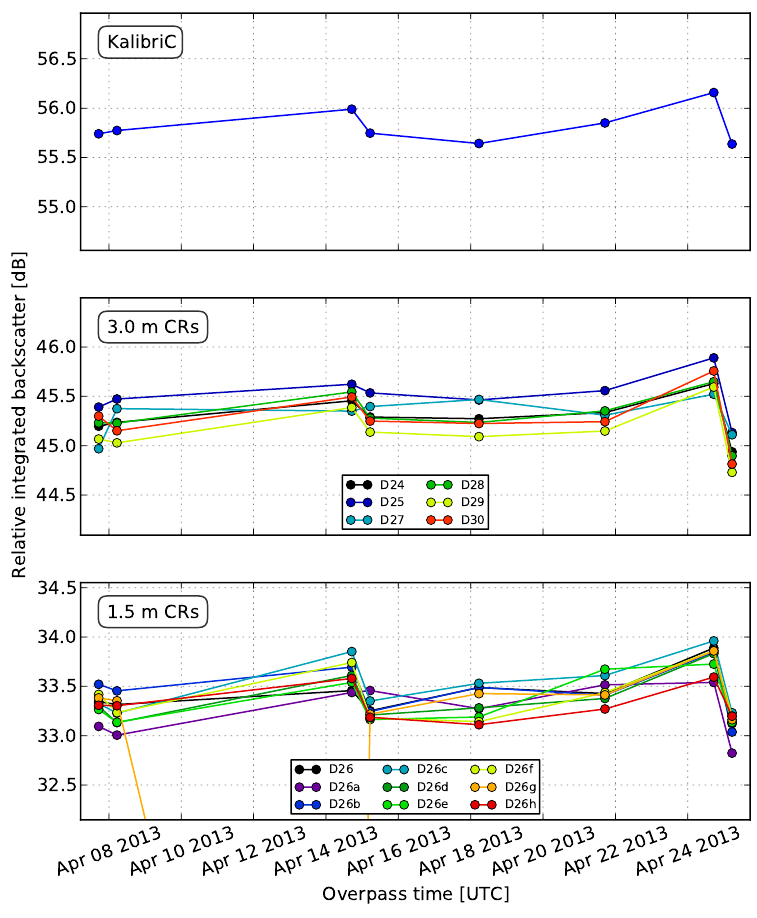
Uncompensated and unmasked data, the immediate result of the processing described in Section 4.2. The data points lie on a common ordinate; for better visibility, one region per target group is plotted. Original